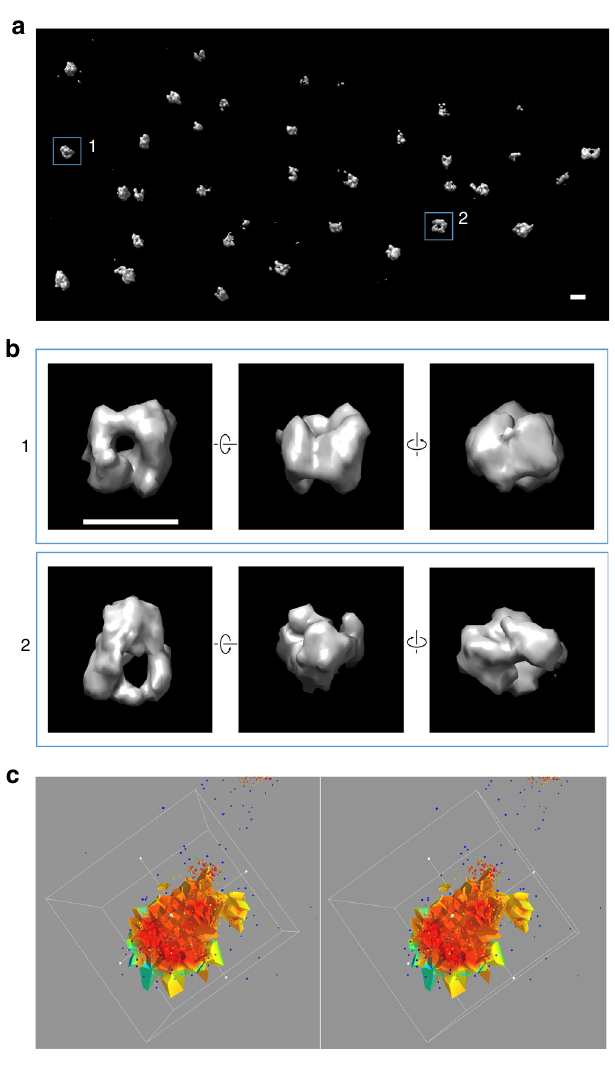
Fig. 3 3D SMLM imaging of CENP-A in a U2OS cell fi xed at 1.5 h after mitosis. a Characteristic 3D rosette-like clusters can be seen. The image is created as a 3D Voronoi-based density map 43 and displayed with the Chimera software 51 ; scale bar: 300 nm. b Zoomed-in images display rotated views of particles, revealing a cavity in the center formed by a CENP-A shell; scale bar: 300 nm. c A 3D Voronoi diagram built on 3D SMLM data of CENP-A (stereo representation); view cut through a cluster; color coding from high (red) to low fl uorophore densities (green). See also Supplementary Fig. 6 for a 3D reconstruction obtained from 2D images that also shows the rosette-like